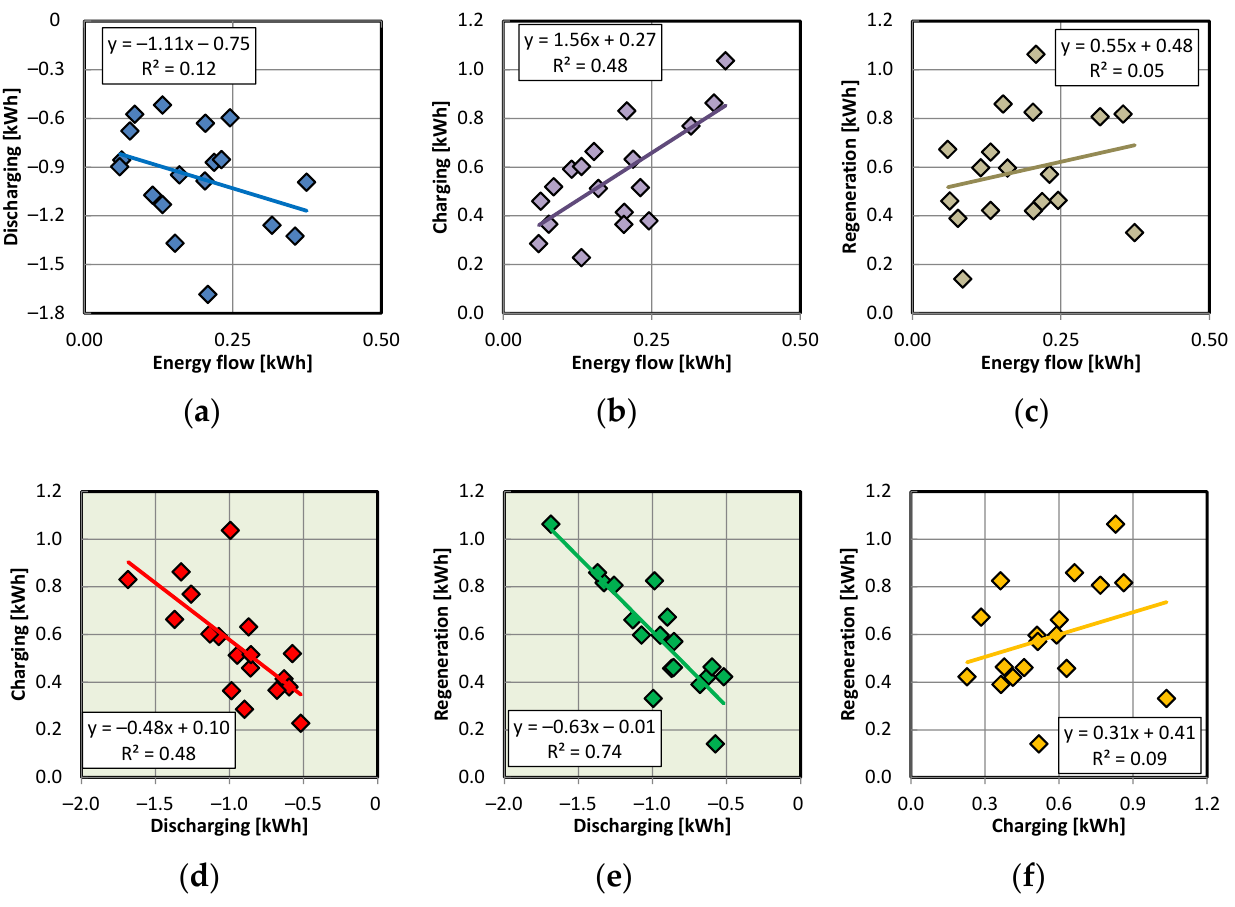
Figure 8. Comparative analysis of the relation: ( a – c ) between total energy flow, discharge energy,